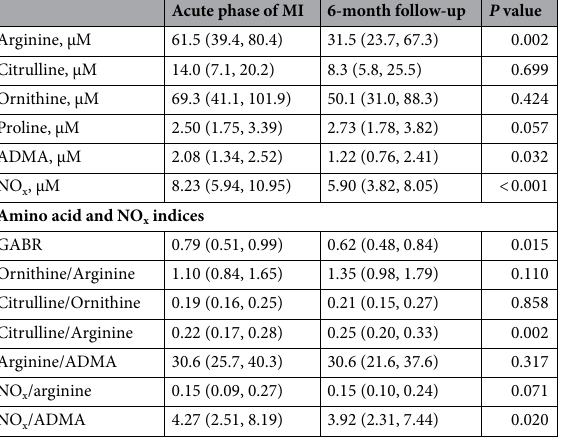
Table 3. Arginine metabolites and their indices. Abbreviations: data are shown as median (interquartile range), ADMA: asymmetric dimethylarginine, GABR: global arginine bioavailability ratio, MI: myocardial infarction, NO x :